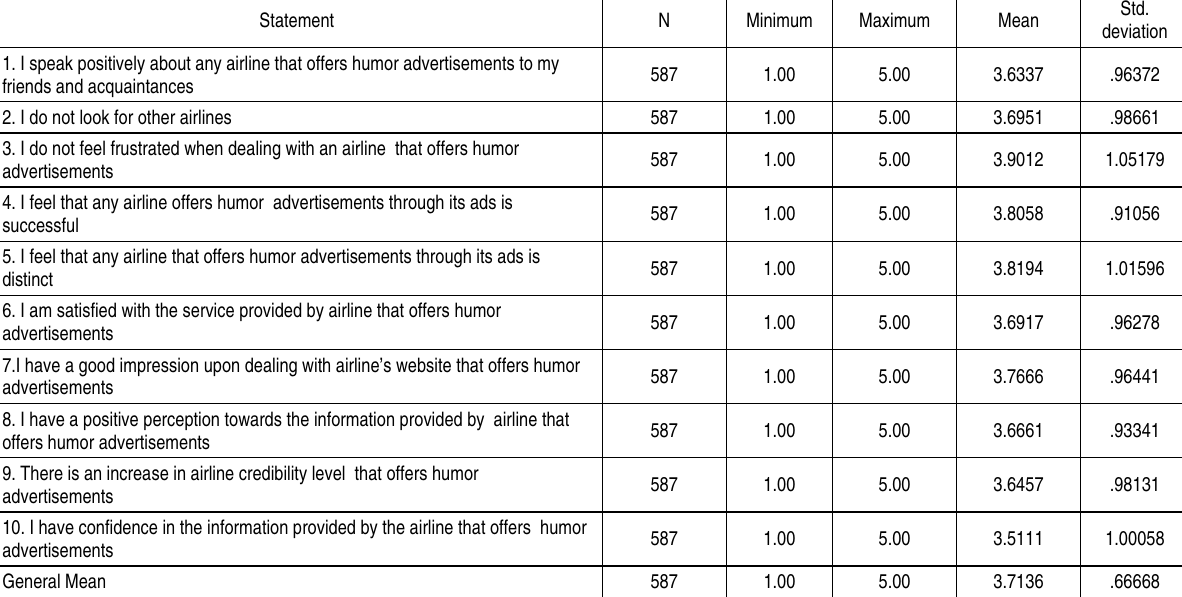
Table 9. Means and standard deviations of sample’s responses regarding the mental image variable